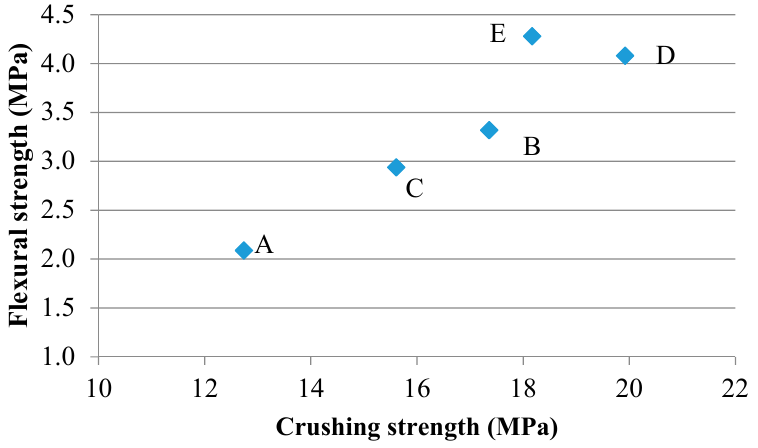
Figure 3. Relation between volume expansion and baked density.